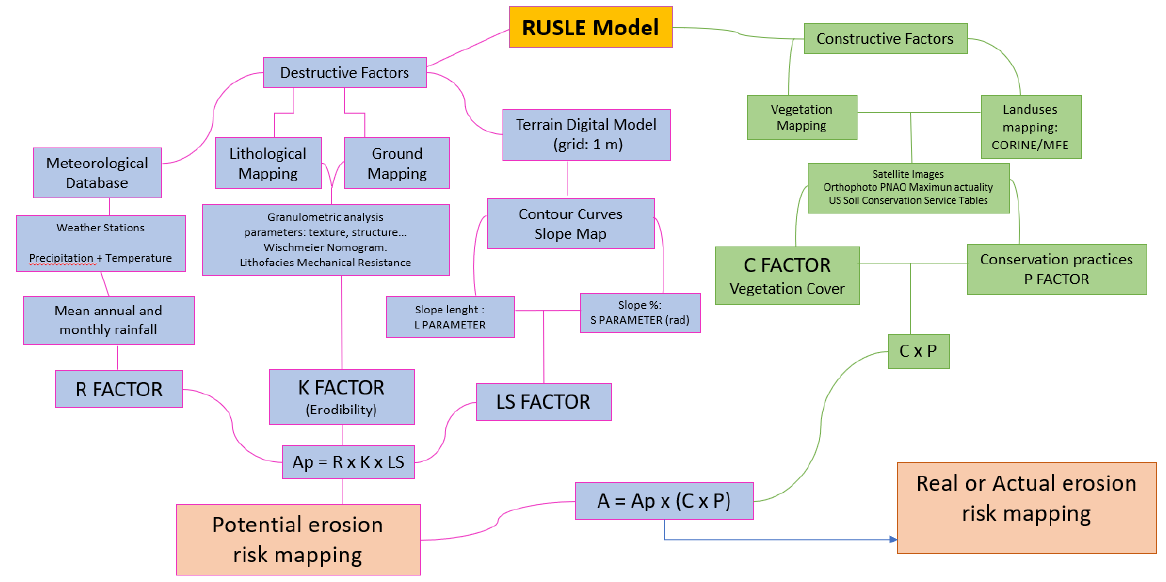
Figure 3. Figure 3. Workflow.